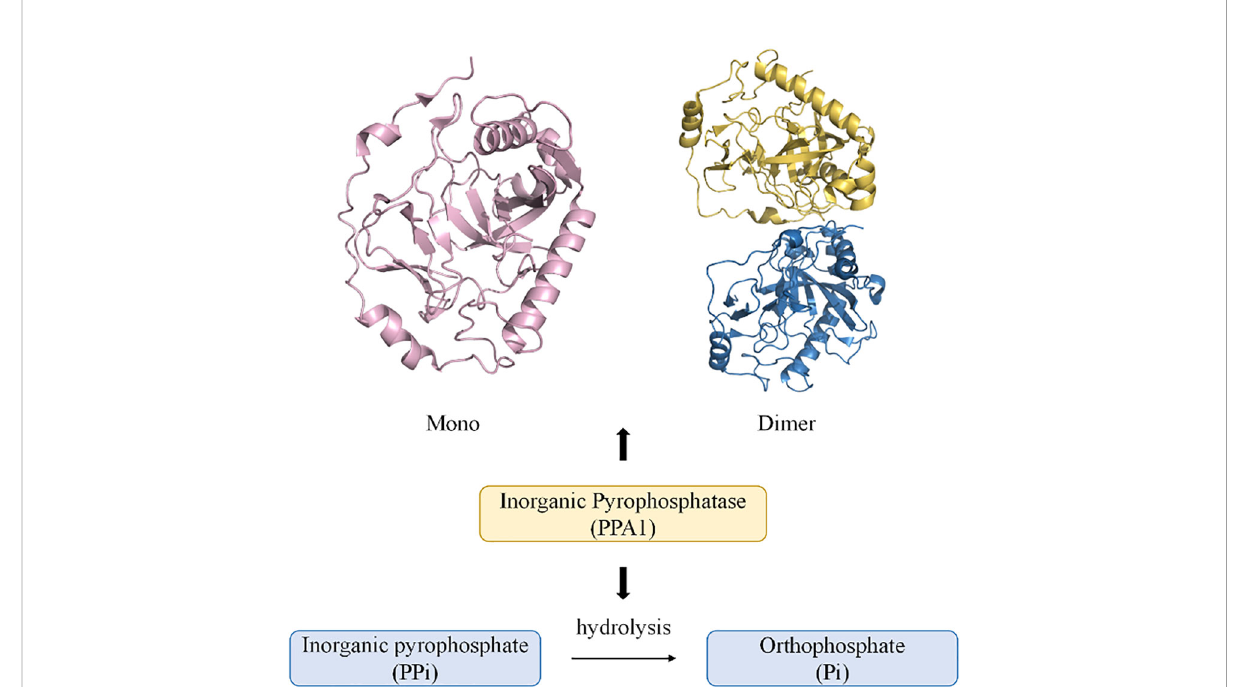
FIGURE 1 Diagram of the monomeric and dimeric structures of PPA1, and their modes of participation in PPi hydrolysis (21). (PDB code: mono 7BTN; dimer